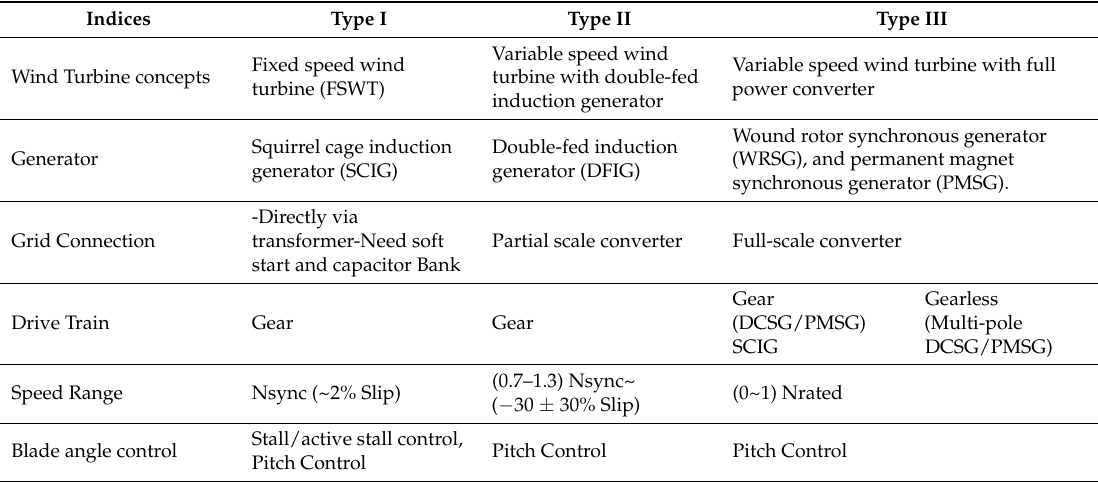
Table 1. The comparison between the types of wind